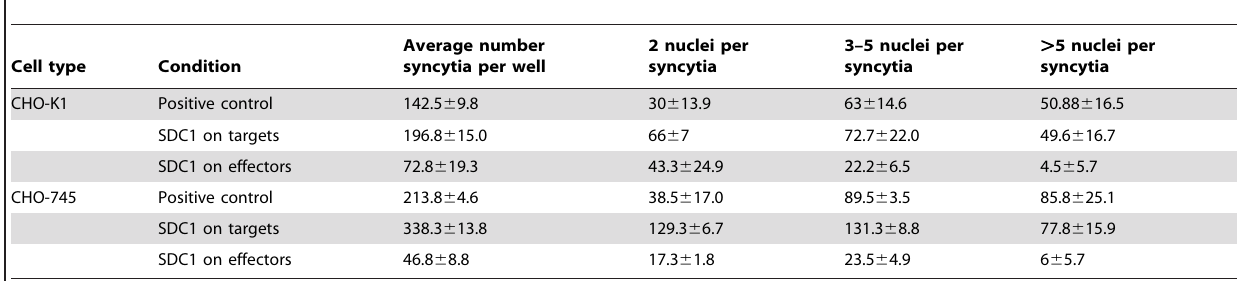
Table 1. Comparison of syncytia number and nuclei count after syndecan-1 overexpression in each CHO cell type.